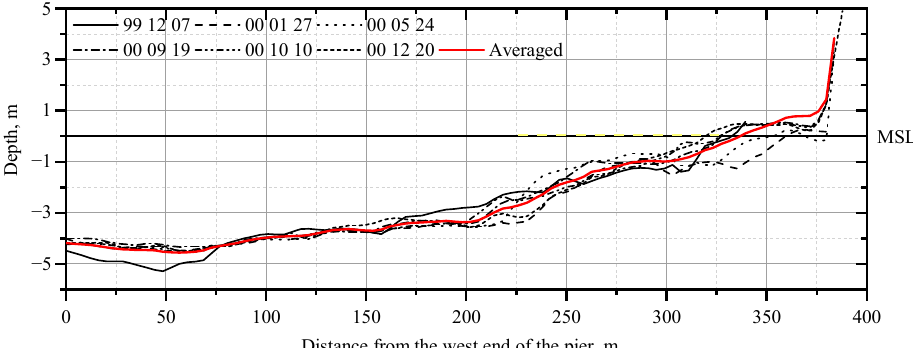
Figure 4. Changes in the beach profiles 1999–2000. The measurement date is indicated in the legend (yy mm dd); here and later, the yellow dash line indicates the length of the groyne.